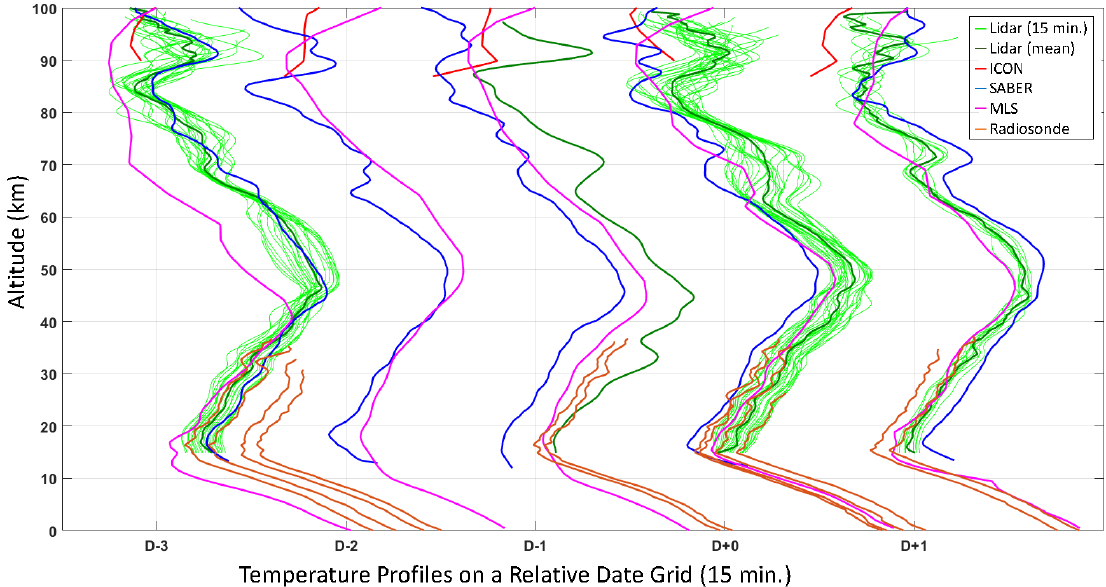
Figure 3. All measurements made during the Monge 2020 campaign. Dates are relative to day zero (D+0) and are re-gridded at 15 min intervals on the ERA5 time